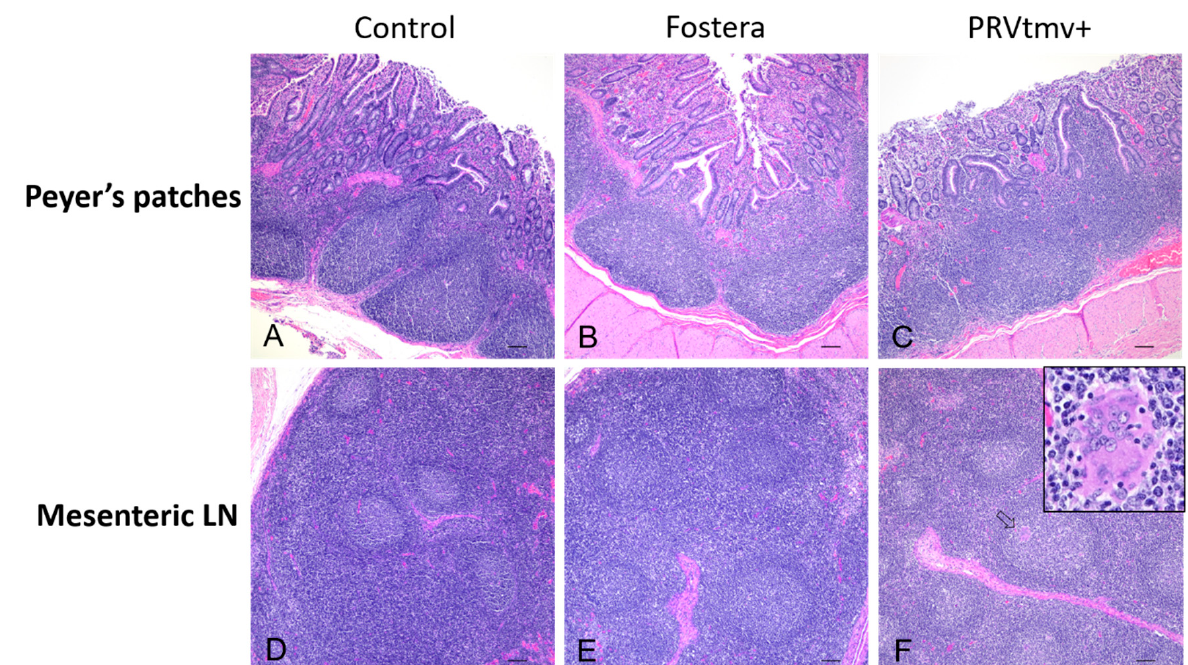
Figure 17. Histopathology following vaccination with Fostera or PRVtmv+ vaccines and subsequent challenge with PCV2. Control group ( A , D ), Fostera-vaccinated group ( B , E ), and PRVtmv+-vaccinated group ( C , F ). Overall, there are no significant histologic changes. Rare multinucleated giant cells were noted in the mesenteric lymph node of one PRVtmv+-vaccinated pig (#2302; F, arrow, and inset) H&E 100× total magnification, Bar = 100 μ m.